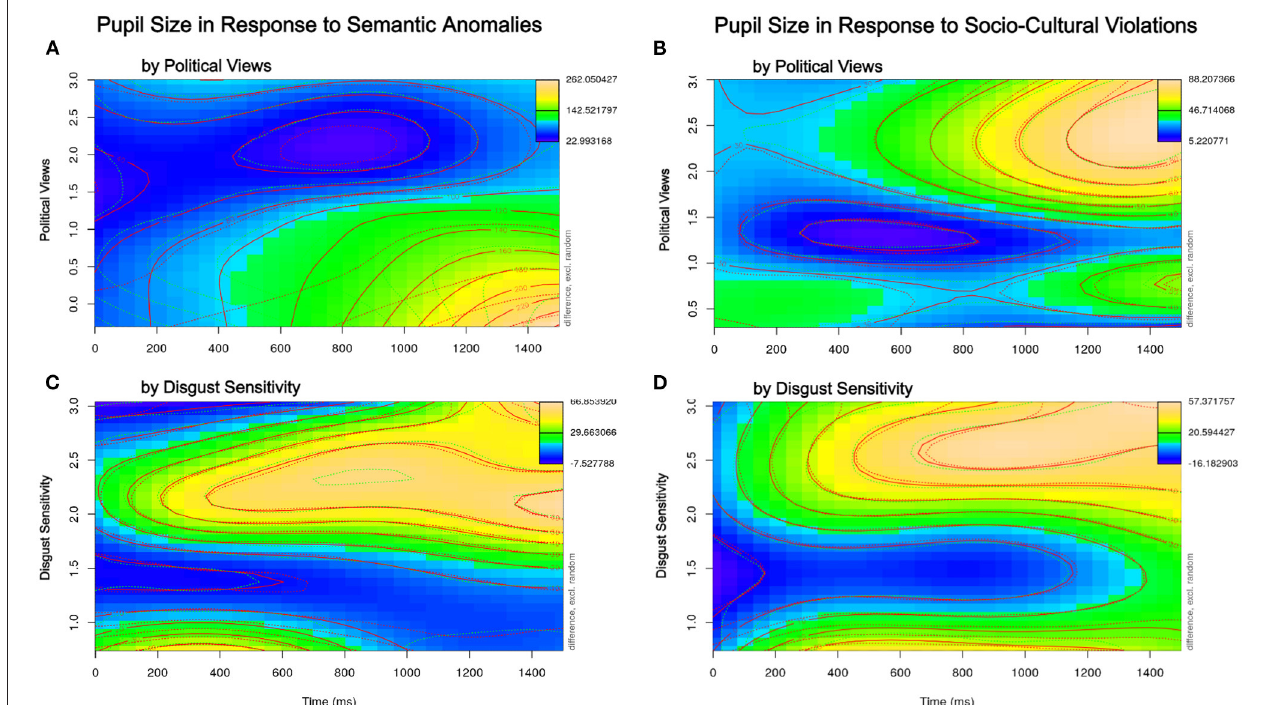
FIGURE 1 | Difference in pupil size in anomalous/clashing conditions compared to non-anomalous/non-clashing conditions by Political Views and Disgust Sensitivity (y-axis) and Time from the onset of the target word (x-axis) for semantic anomalies ( A,C , respectively) and socio-cultural clashes ( B,D ,